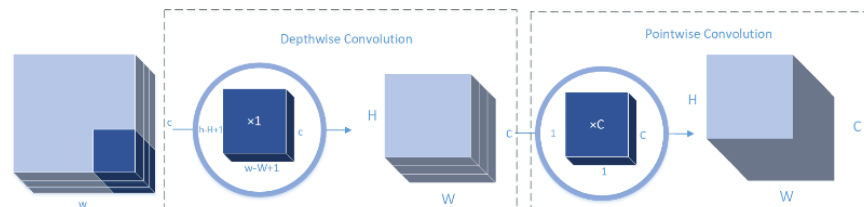
Figure 2. MBConv internal structure.